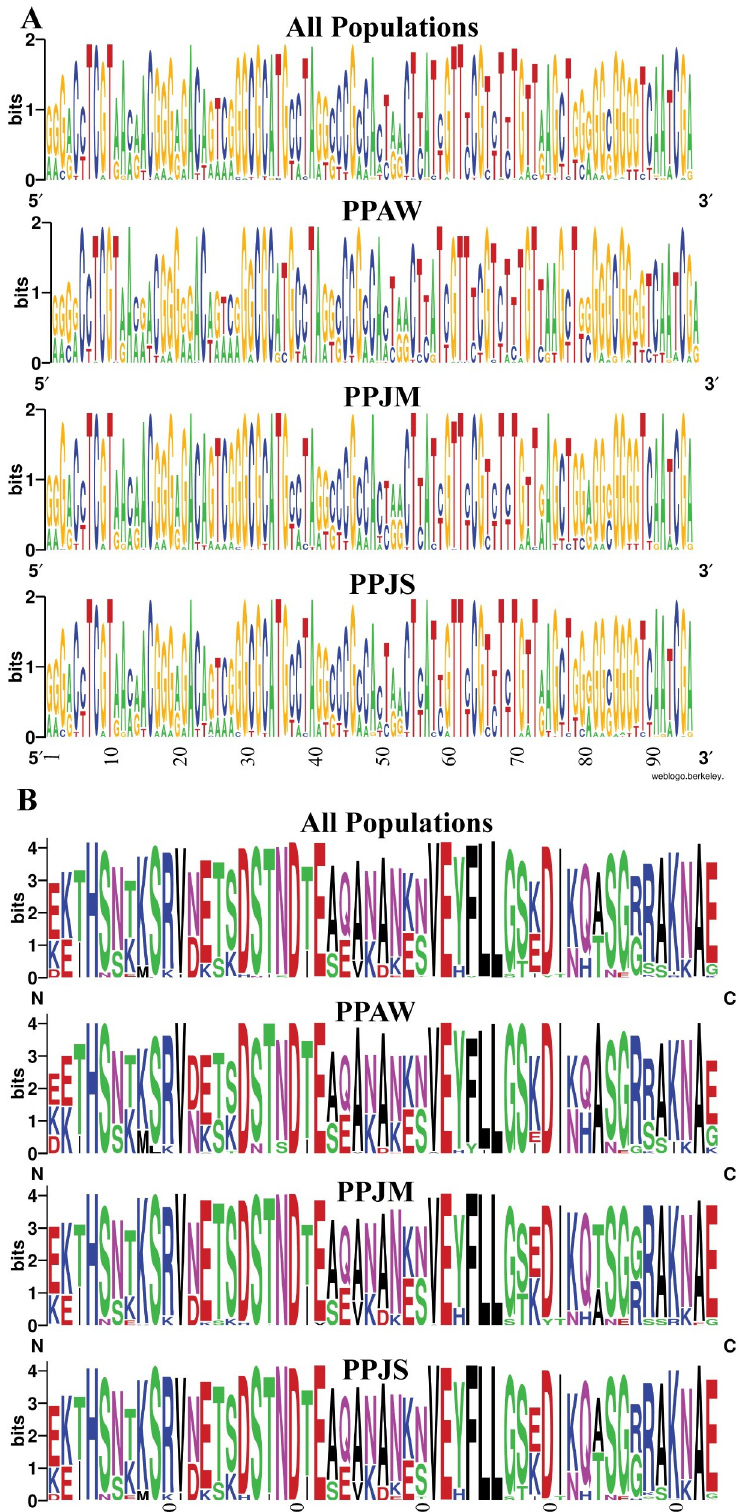
Fig 8. PpSP28 nucleotide and amino acid variation. (A) Weblogo illustrating the relative frequencies of nucleotide polymorphisms in wild caught P . papatasi populations from PPAW, PPJM, and PPJS. (B) Weblogo illustrating